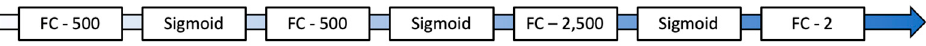
Figure A12. Illustration of the encoder of parametric t-SNE. FC: fully connected layer with the number of nodes indicated; Sigmoid: sigmoid activation.